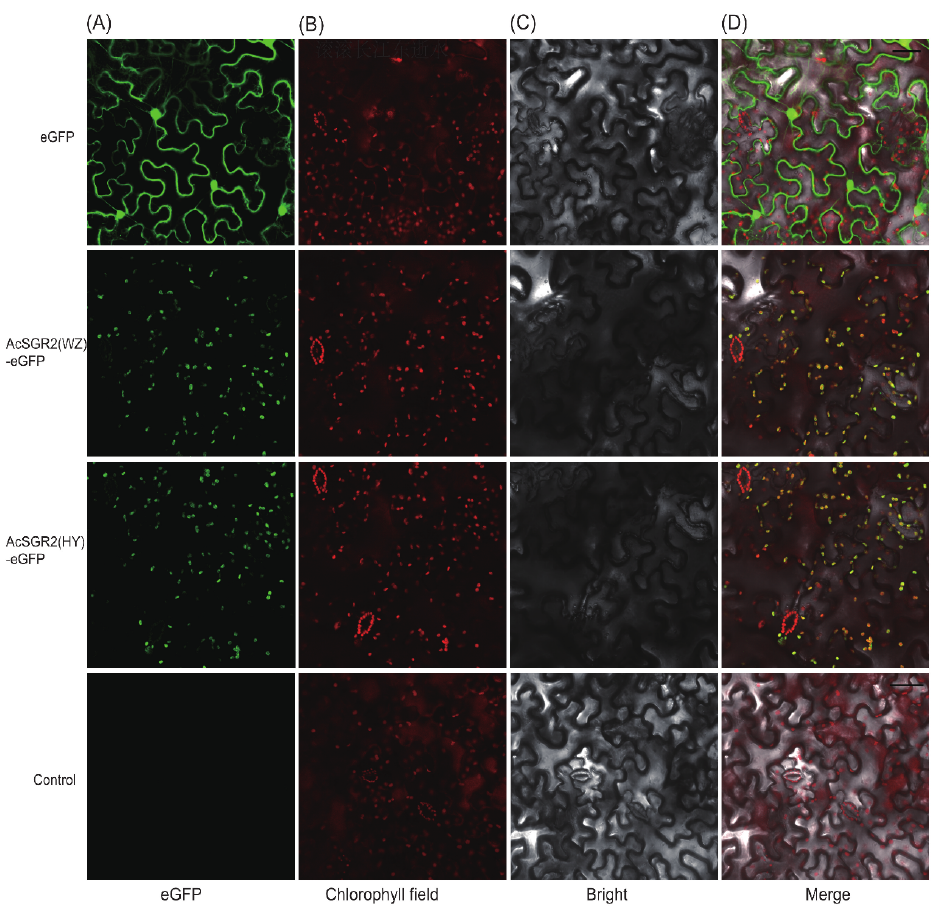
Figure 7. Subcellular localization of the fusion protein 35S:: AcSGR2-eGFP in tobacco leaves. Images were taken under ( A ) fluorescence, ( B ) Chl field, ( C ) bright field, and ( D ) Merged field. The Chl autofluorescence was used to localize chloroplasts. WZ, ‘Wuzhi no.3’; HY, ‘Hongyang’; eGFP, enhanced green fluorescence protein; AcSGR2(WZ), AcSGR2 from WZ; AcSGR2(HY), AcSGR2 from HY; Bars = 50 μ m.